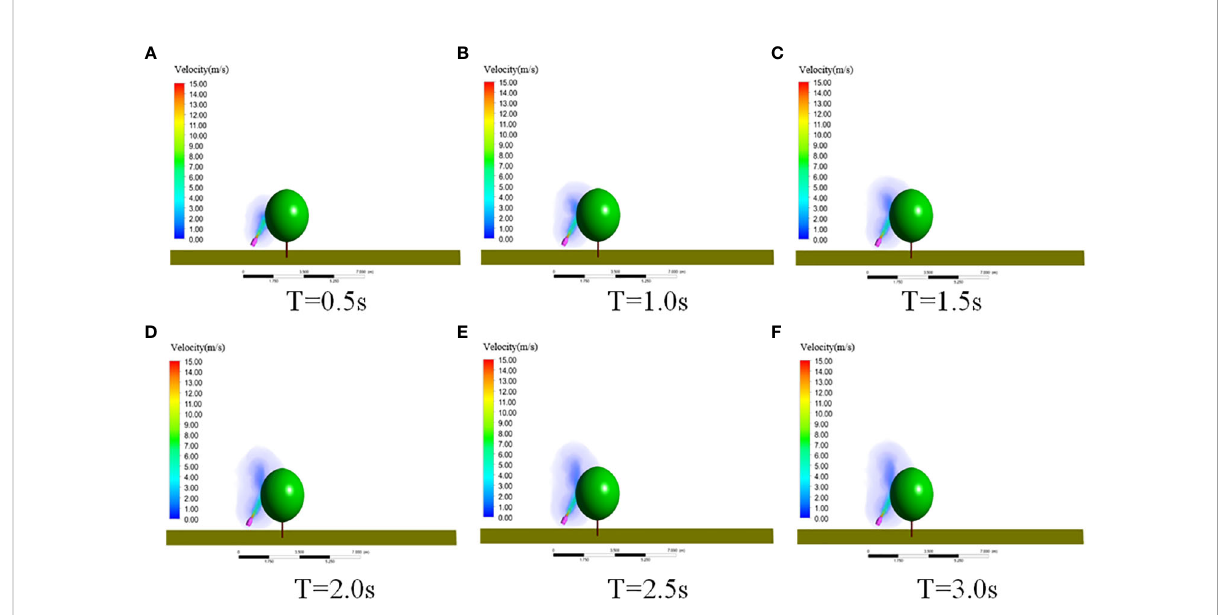
FIGURE 10 Wind speed distribution of the swing-arm sprayer at different times. (A) T=0.5s. (B) T=1.0s. (C) T=1.5s. (D) T=2.0s. (E) T=2.5s. (F)